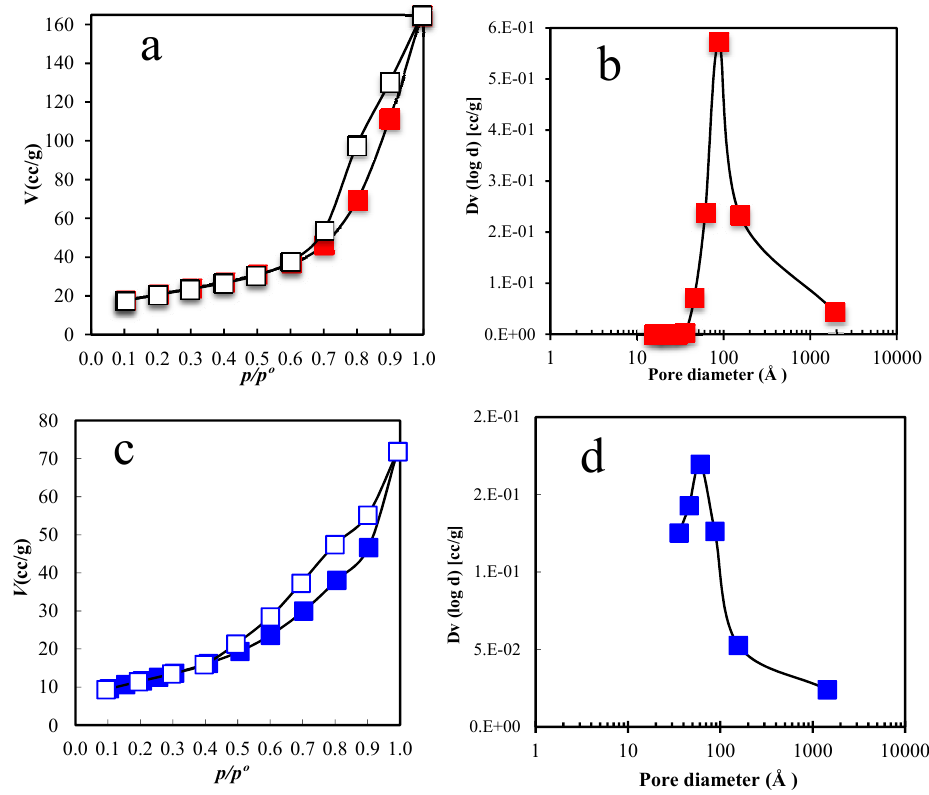
O ; and ( d ) Cu/Al 2 3